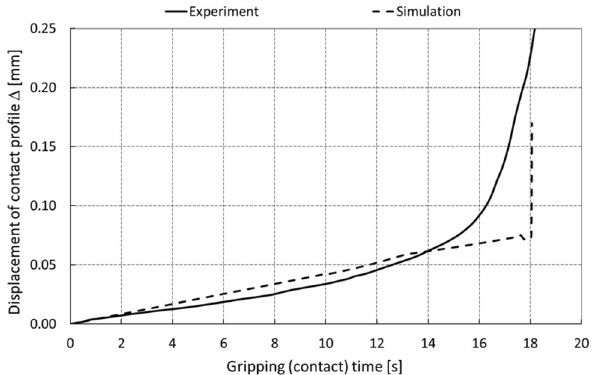
Fig. 22 Development of the contact collapse